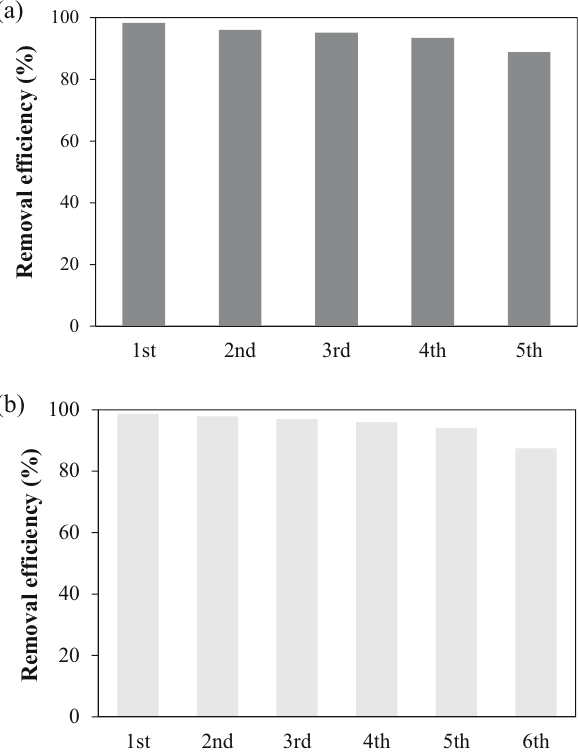
Figure 11: The removal e ffi ciency of MO after four times ( a ) and MB after fi ve times ( b ) reusing of CuCo - ZIFs. MO: pH 7.0, catalyst